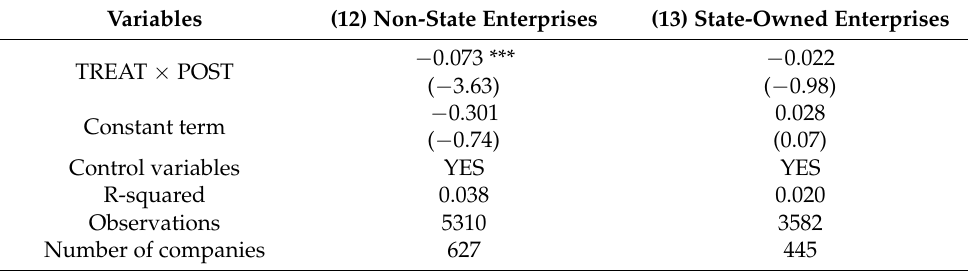
Table 7. Results of the test for heterogeneity of corporate property